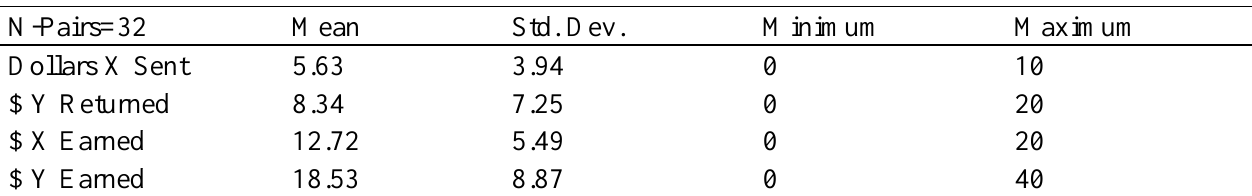
Table A1. Summary data for strategy method treatments CH1 and